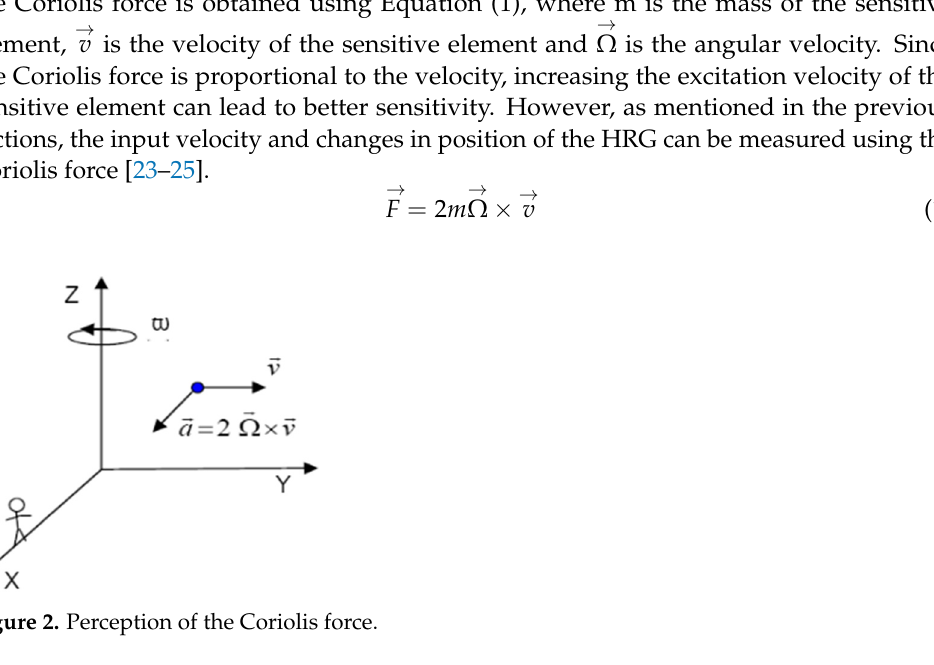
Figure 3. Linear movements of the proof mass. Three-Dimensional Finite Element Analysis An HRG in a spherical coordinate system is shown in Figure 4. Constants E, 𝜌 and 𝜇 are Young’s modulus, air density and Poisson’s ratio, respectively. 𝑅 and ℎ are the radius and thickness of the resonator, respectively. If the changes in the Coriolis force and the angular acceleration equations are combined, then the frequencies of the differ- ent HRG modes are given by [17,18] 𝜔 = (cid:3498) 𝑛 (cid:2870) (𝑛 (cid:2870) − 1) (cid:2870) 𝐸 (cid:1516)